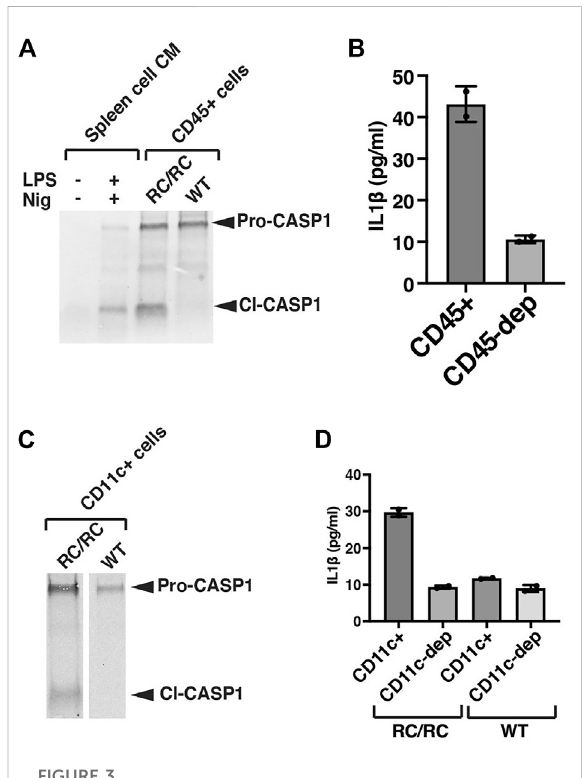
FIGURE 3 CD11c+ macrophages and dendritic cells are responsible for in fl ammasome activation in RC/RC cystic kidneys. (A) CD45 + MACS (magnetic cell separation) cells were puri fi ed from single kidneys of female RC/RC or WT mice prior to immunoblot analysis (100,000 cells/lane) using an antibody speci fi c for Caspase-1. This experiment was carried out on 4 separate occasionswithsimilarresults. Ascontrolsamples,singlecellswere prepared from mouse spleens and either treated or not in vitro with LPS and nigericin to stimulate in fl ammasome activation. Conditioned media from these cells were collected and concentrated prior to immunoblot analysis. (B) CD45 + cells were puri fi ed from single kidneys of female RC/RC mice by MACS column as in (A) and equal numbers (100,000) of these cells and those left after passing through the column (CD45-depleted, dep)